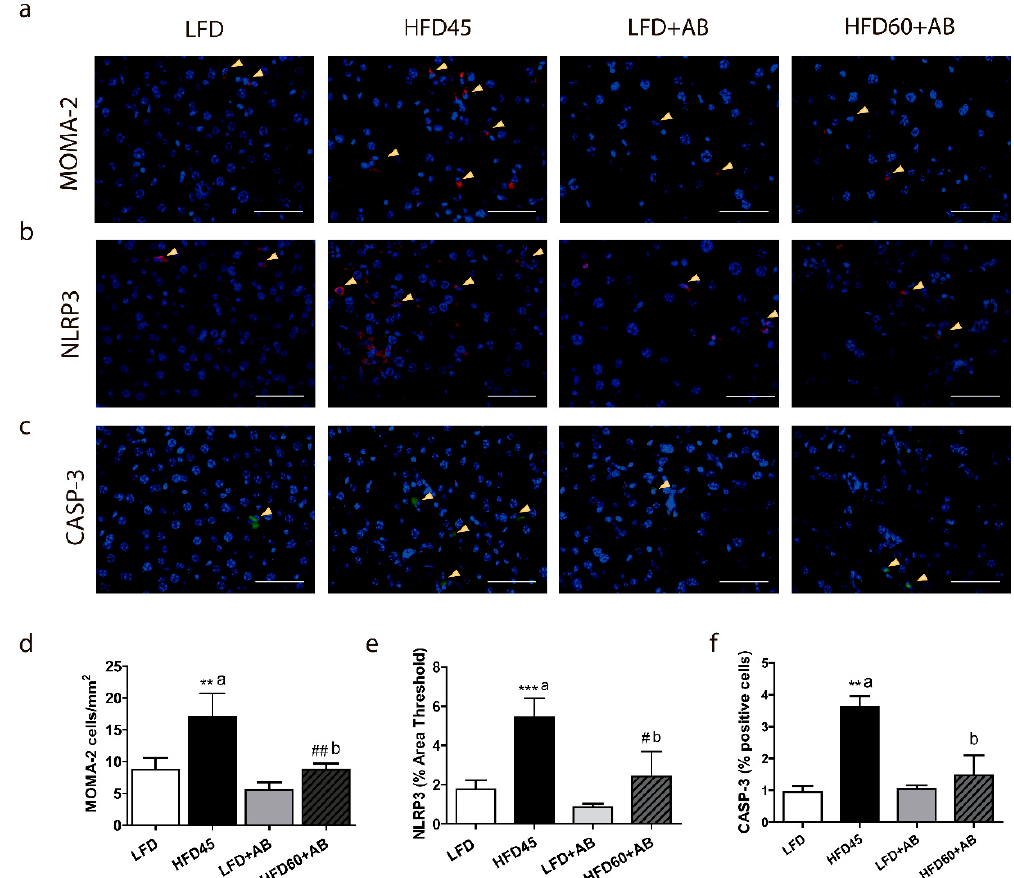
Figure 4. Histological analysis of liver inflammation and apoptosis induced by the HFD-L diets in LDLR -/- mice after 12 weeks of nutritional intervention with AB extract. Immunofluorescence showing ( a ) MOMA2 infiltration (red), ( b ) NLRP3-positive cells (red), and ( c ) CASP-3-positive cells (green). Nuclei were counterstained with DAPI (blue) (40 × , scale bar = 100 µ m). ( d ) Quantification of MOMA-2-positive cells. ( e ) Percent areas of NLRP3-positive cells. ( f ) Quantification of CASP-3-positive cells. All data are shown as the means ± SD ( n = 5). ** p ≤ 0.01/*** p ≤ 0.001 vs. LFD; # p ≤ 0.05/## p ≤ 0.01 vs. LFD+AB. Different letters indicate significant differences among the HFD groups ( p ≤ 0.05).